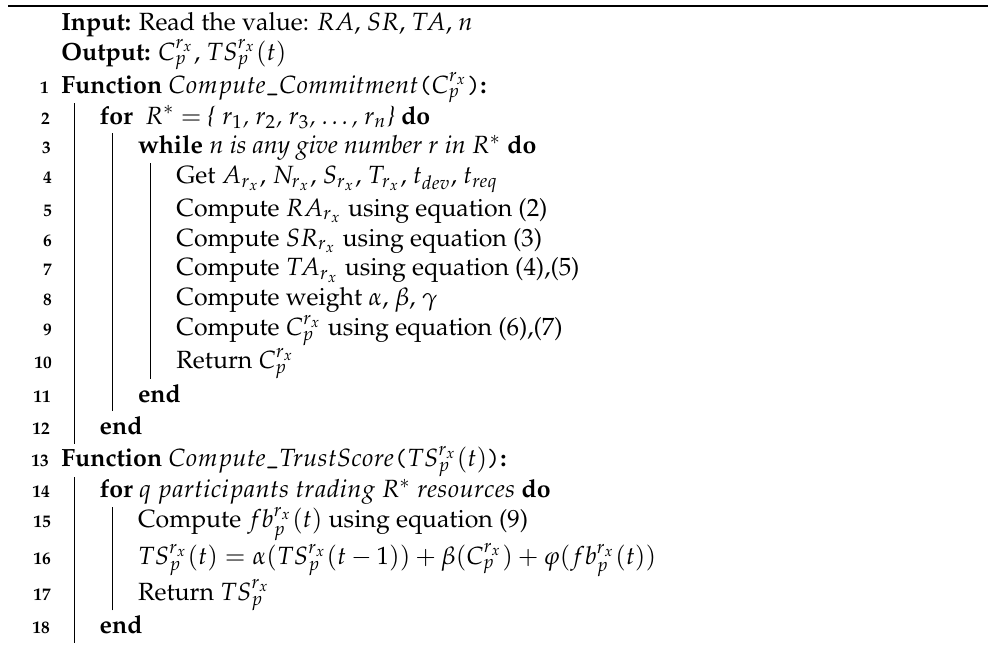
Algorithm 1: Computing trust score for SMP